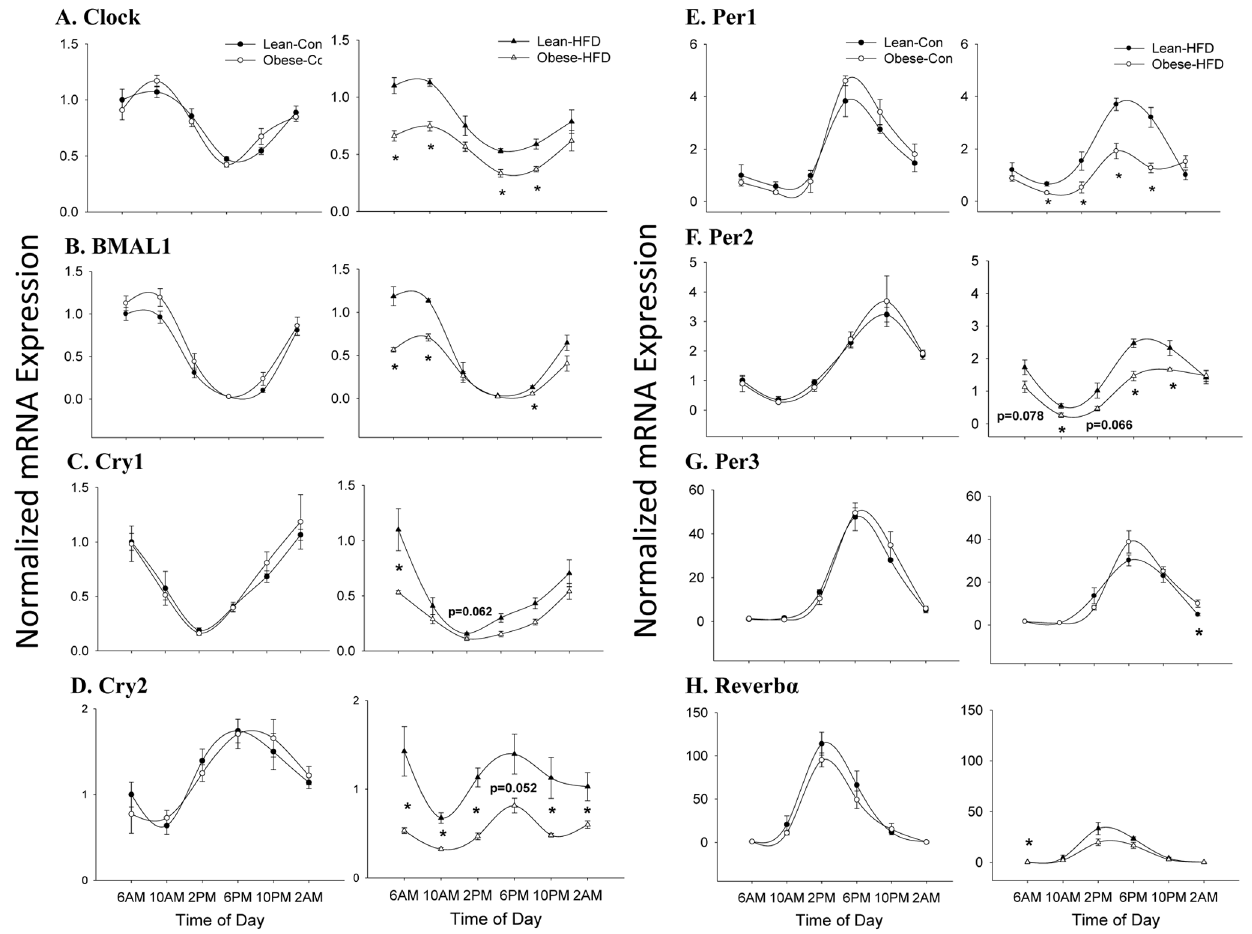
Figure 2. Hepatic mRNA expression of core circadian genes. mRNA expression was assessed in lean and obese dam offspring (A–H) fed either control or high fat diets (HFD) from weaning through PND35 (N=3–5 animals per group, Lean-Con 2AM and Obese-HFD 6AM (N=5 per group), Lean- Con 10AM and Obese-Con 10PM (N=3 per group), and all the remaining groups (N=4)). Gene expression was assessed via real-time RT-PCR. All genes were normalized to SRP14 and expressed relative to Lean-Con at 6AM. Data are presented as mean 6 SEM Statistical differences were determined using a Student’s t test. * denotes significance, P , 0.05.